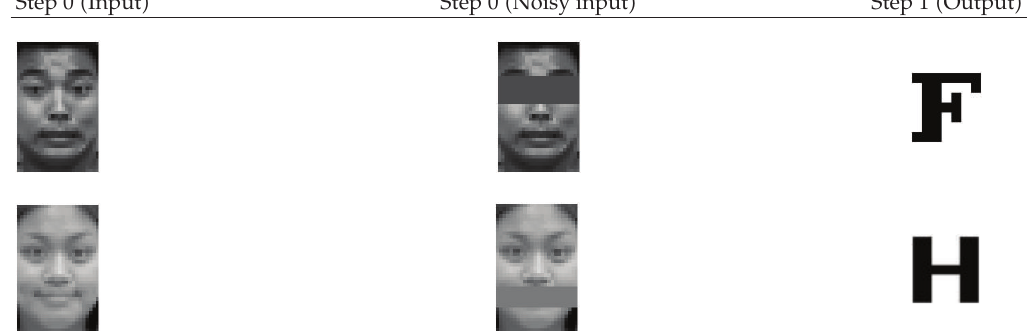
Table 6: Network recall when important feature is removed (cid:3) eyes and mouth (cid:4) . Step 0 (cid:3) Input (cid:4)